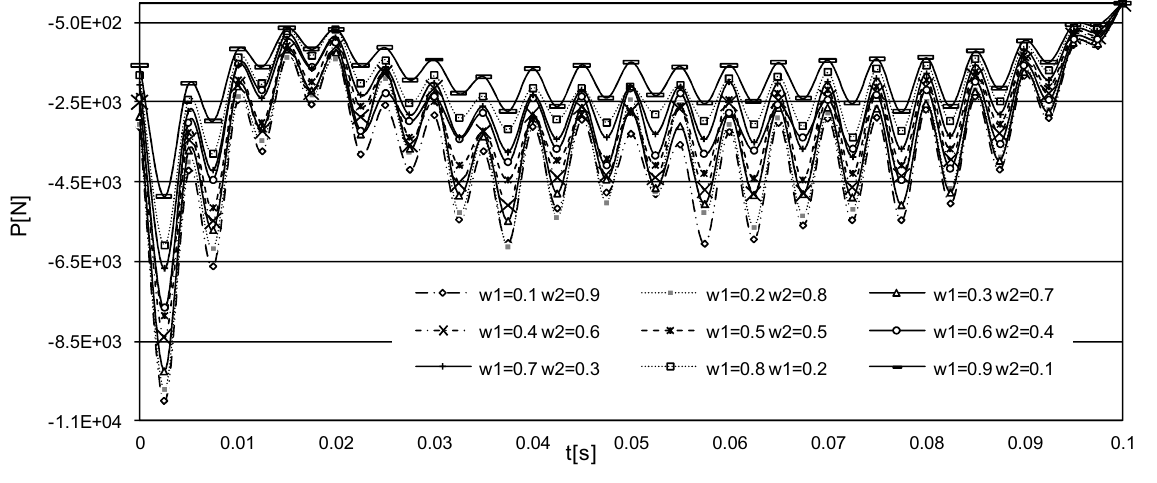
Fig. 4. Optimum control force without preview control with the min-max upper bound